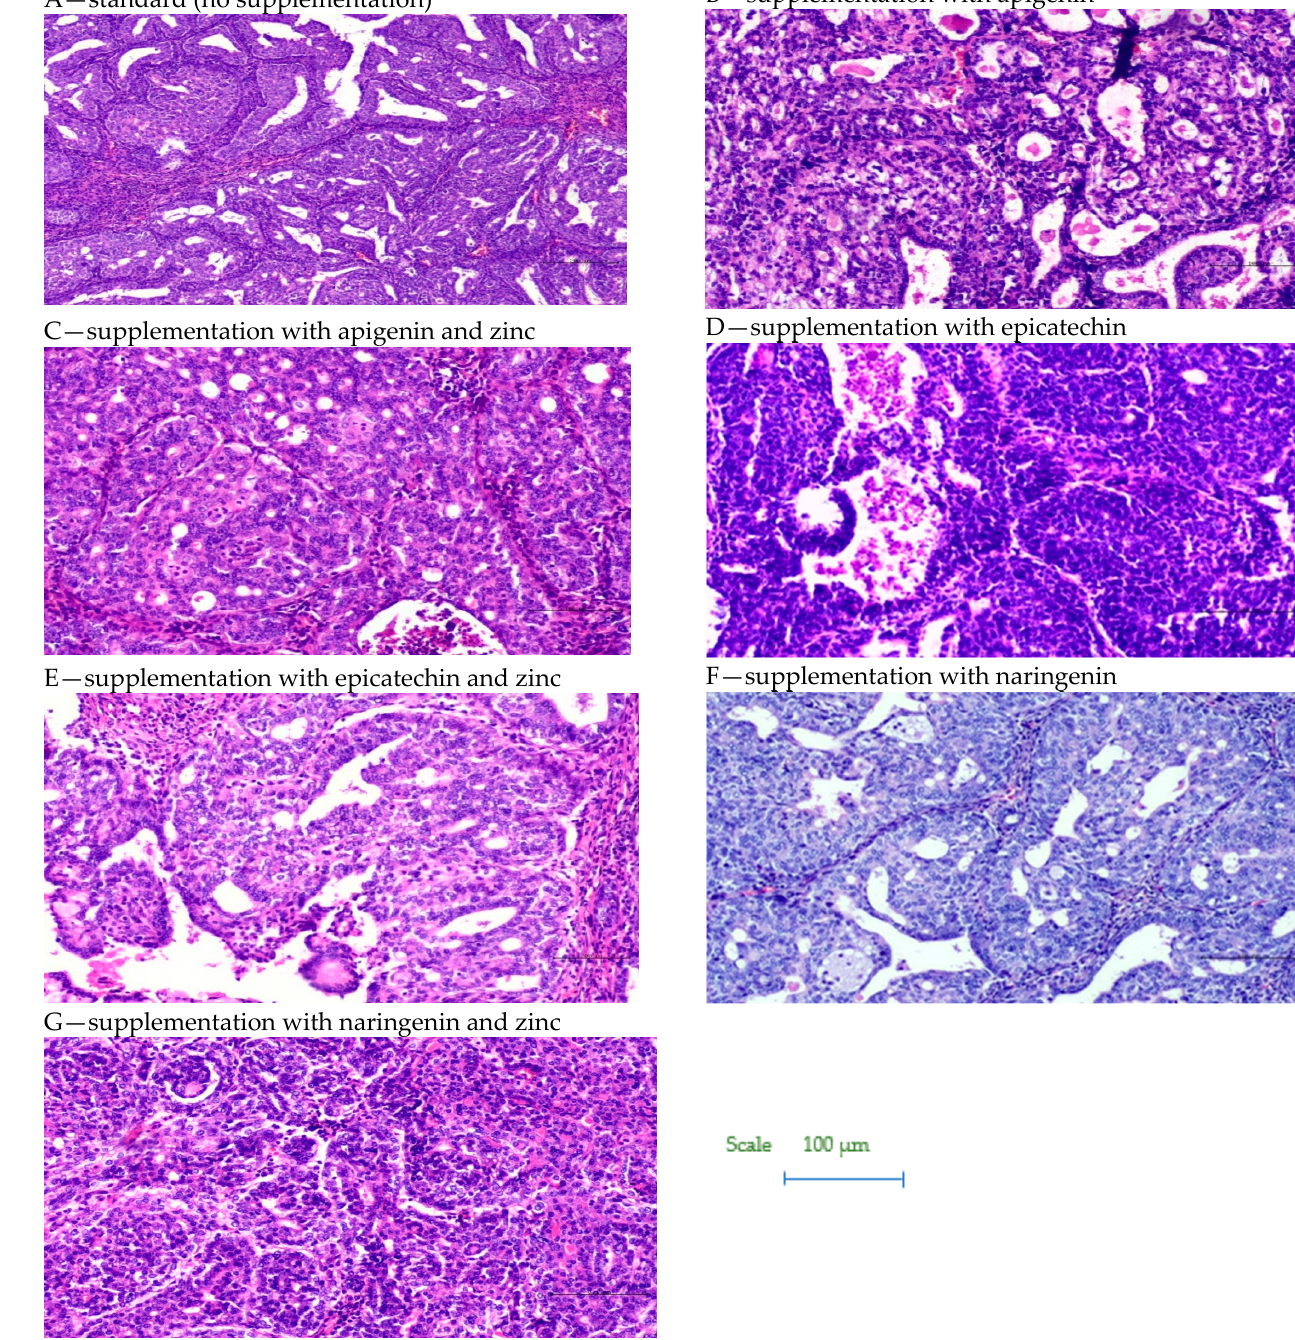
Figure 3. Biopsy images of tumor samples with 10× magnification.